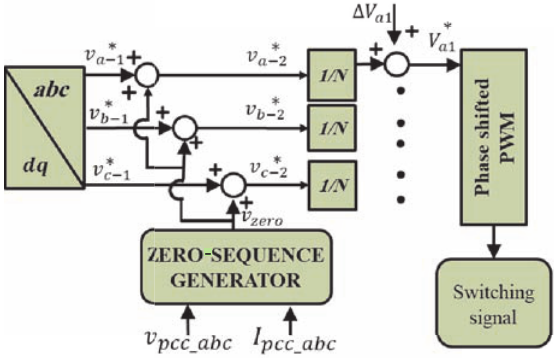
Fig. 5. Inter-pphase and inter-bridge voltage reguulation.